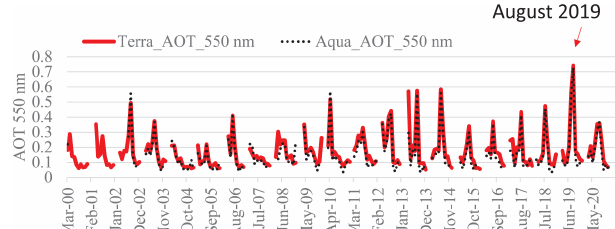
Figure 2. Monthly and regional mean 550nm AOT measured with MODIS on board Aqua and Terra (MODIS, 2021) in central and eastern Siberia from March 2000 to December 2020. The consid- ered region is defined by the latitudes from 55–72 ◦ N and longitudes from 100–138 ◦ north of Lake Baikal (53.5 ◦ N, 108 ◦ E).